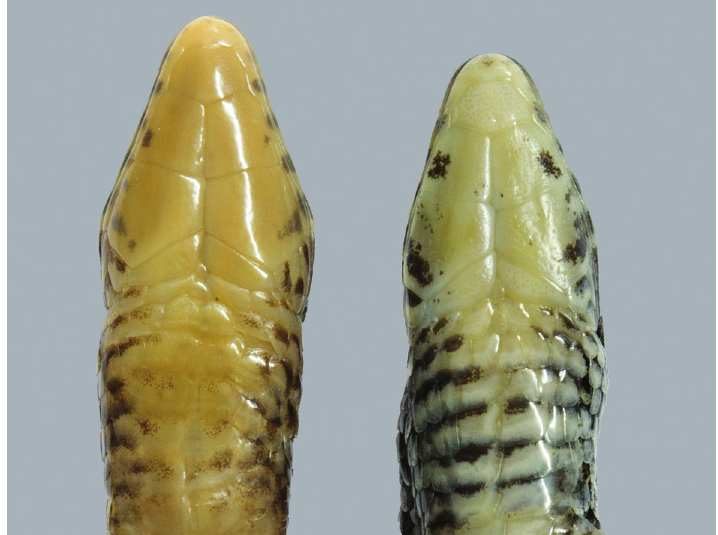
Figure 5. Ventral view of the head showing the different coloration pattern between Colobosaura modesta (MNHNP 8521, left) and C. kraepelini (MNHNP 11726, right). orly, and a diffuse Vandyke Brown (282) line edging anterior margin of frontal and second supraocular and anterior scales; lateral parts of the head homogeneous Vandyke Brown (282); supralabials with Medium Neutral Gray (298) bars in the center inter- leaved with Cyan White (155) in the sutures; background color of mandibular region Cyan White (155) with Medium Neutral Gray (298) blotches on infralabials (one per scale) and second pair of chin shields; iris Burnt Umber (48); dorsal scales Mikado Brown (42), anteriorly (before forelimbs level) with Vandyke Brown (282) suffusions more concentrated near the laterals, and posteriorly (after forelimbs level) with faint irregular suffusions of Warm Sepia (40), more regularly present on the scales margins; lateral sides of the neck and body Vandyke Brown (282) with irregular Mikado Brown (42) speckles and blotches after forelimbs level, grading into a reticulated Vandyke Brown (282) and Mikado Brown (42) pattern near the groin; background ventral color Cyan White (155) with intrusions of Vandyke Brown (282) on the throat, and a faint mottling of Vandyke Brown (282) on the lateral rows of ventral scales; fore- limbs mostly Vandyke Brown (282), Cyan White (155) restricted to the anteroventral regions; hind limbs Mikado Brown (42) with suffusion of Vandyke Brown (282) on the scales margins, and Cyan White (155) on the ventral region of the limb; tail back- ground color Plumbeous (295) with Brownish Olive (292) suffusions on the anterior third of the organ, and Pale Greenish White (97) paravertebral spots located every two scales; iridescent hue all along the body. Coloration in preservative of the neotype. (After five years in 70% ethanol): The general pattern remains the same, and the background Mikado Brown (42) color also remains; the darker parts of the body (lateral sides of neck and body) turned to